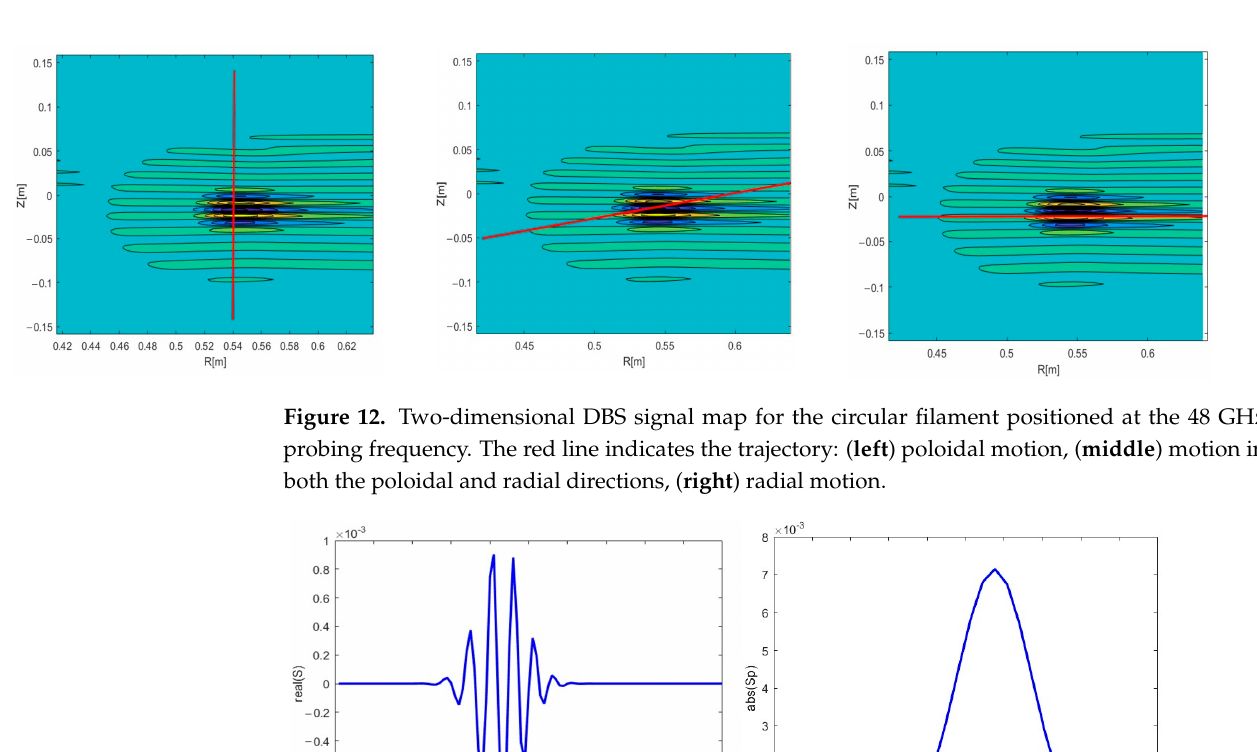
11 of 27 Figure 11. For the circular filament, the dependency of the signal amplitude (black line, scale on the left) and frequency (red line, scale on the right) on the radial position of the circular filament ( left ) with an amplitude of 1% of density at cutoff of the probing wave 48 GHz where the filament was positioned, and ( right ) a filament with an amplitude of 100%. The horizontal red line is the fre- quency predicted by the formula for the Doppler shift in the Born approximation. 3.2. Two-dimensional Motion of the Filament Experiments on various tokamaks demonstrated that filaments can travel both in the poloidal and the radial directions [17]. Complex trajectories were also observed, where the filaments had both velocity components. These observations made this an aspect of